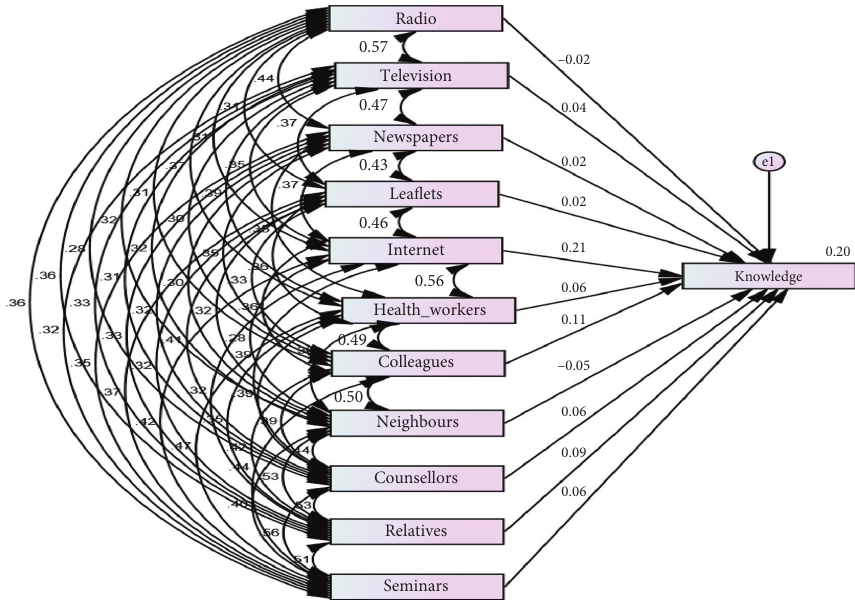
Figure 1: Health communication channels and residents’ knowledge on the hepatitis B virus model. Table 3: Standardized regression weights of health communication channels and knowledge on hepatitis B